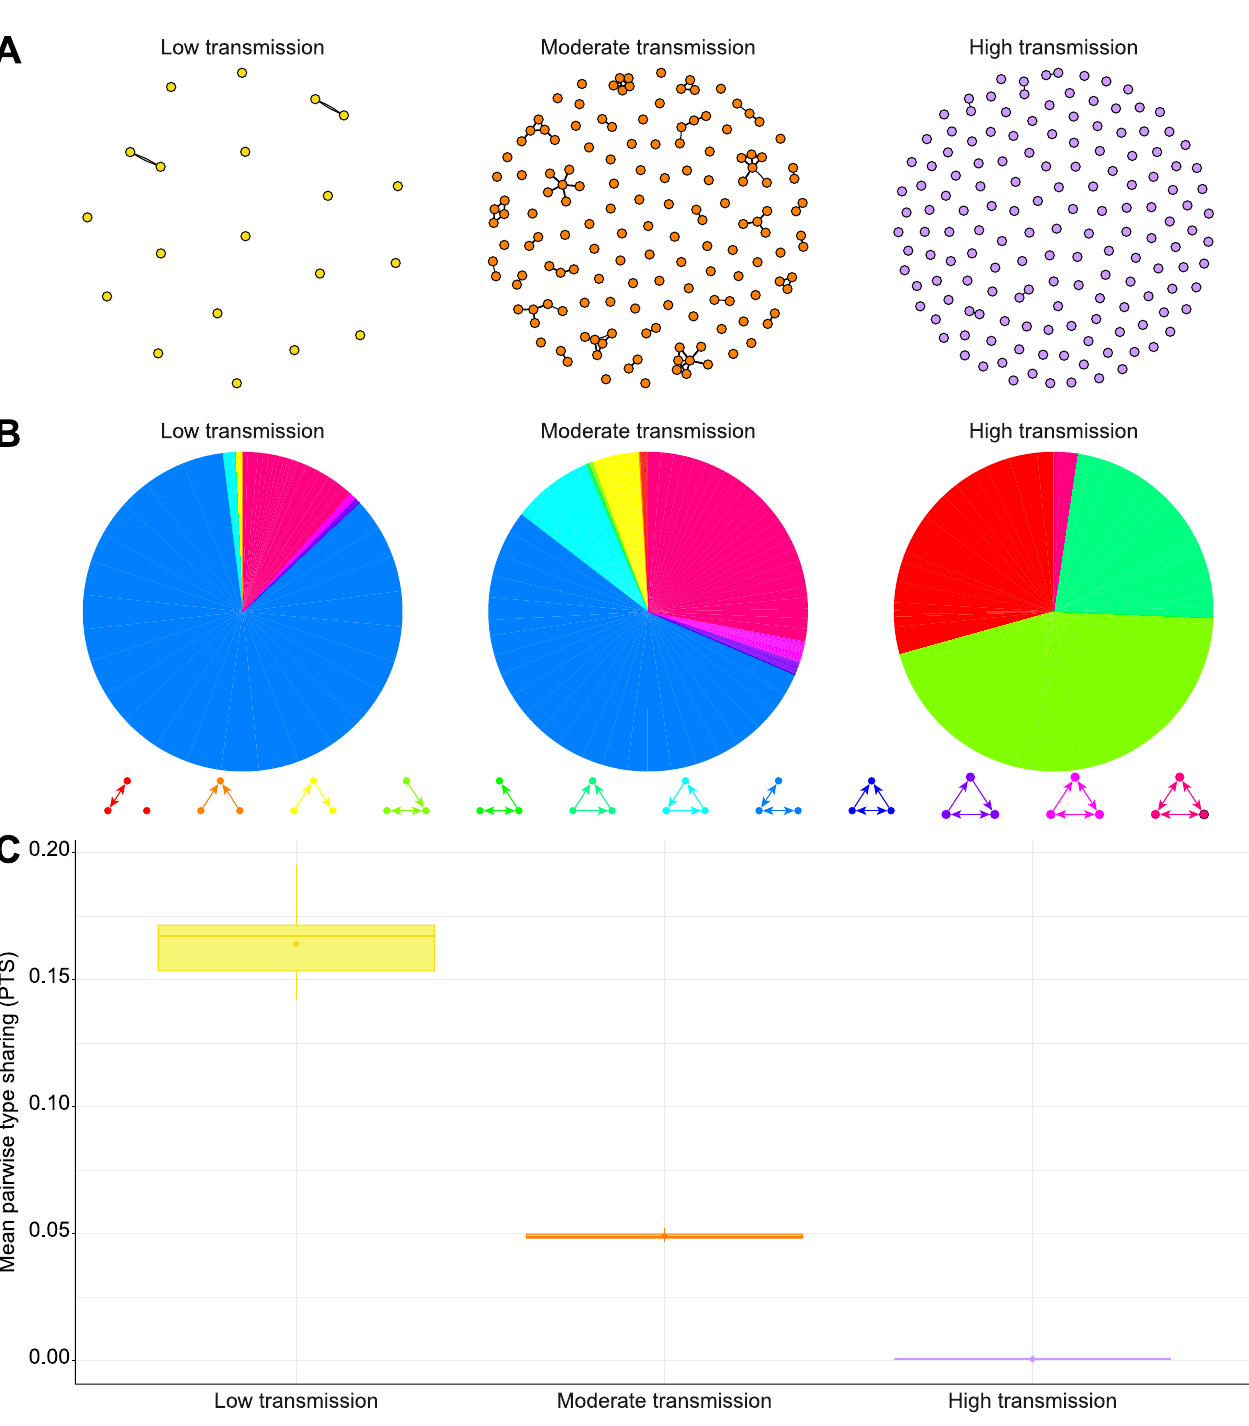
PLOS Computational Biology | https://doi.org/10.1371/journal.pcbi.1010816 January3, 2023 11 /